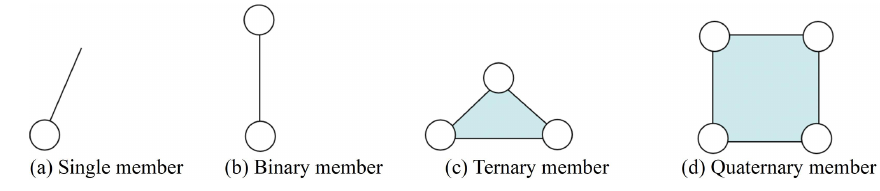
Figure 1. Expression by chains.